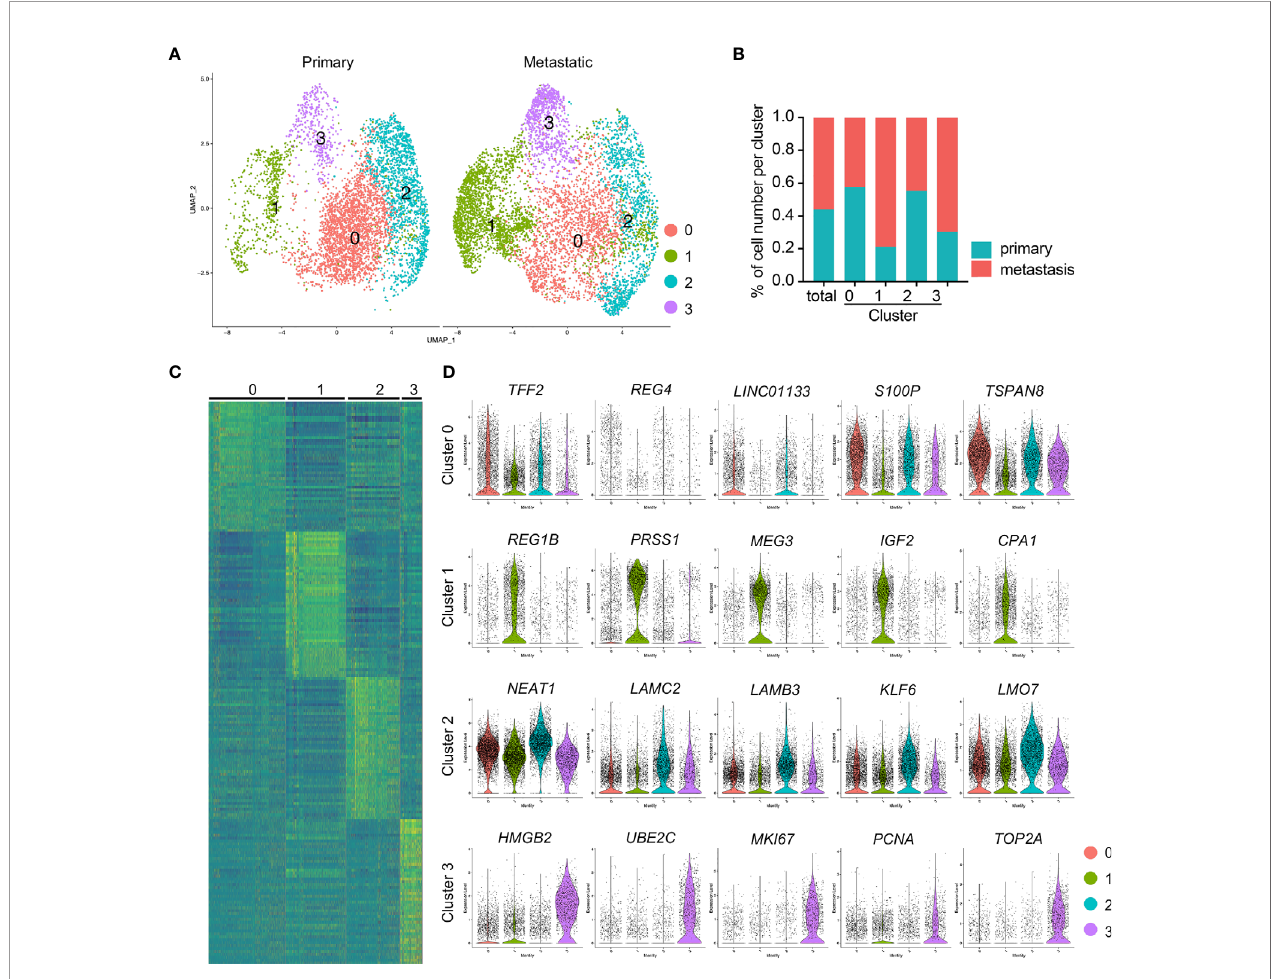
FIGURE 3 | Identi fi cation of cancer cell subclusters PDAC cancer cells. (A) Cell clusters of primary and metastatic PDAC cancer cells were visualized by spilt UMAPs. (B) Percentage of the primary and metastatic cancer cells in each cluster. (C) Heatmap of top 50 genes of each cluster. (D) Presenting of relative expression of representative top genes of each cancer cell cluster. Notably, lincRNAs, LINC01133 , MEG3 and NEAT1 , were the top genes of Clusters 0, 1 and 2, respectively. Cluster 3 exhibited signi fi cantly increased expression of proliferating marker